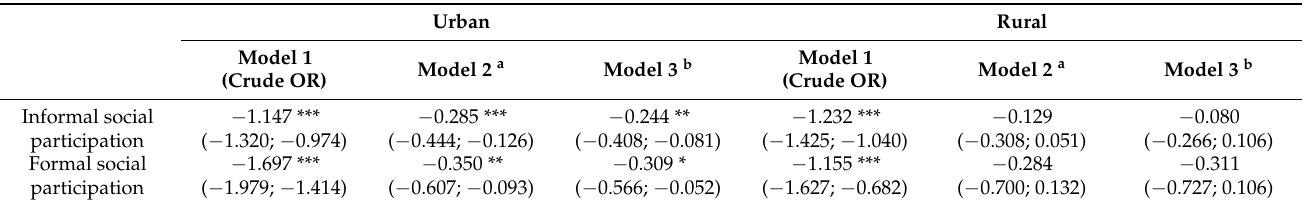
Table 3. Multiple linear regression analysis of the association between social participation and remaining teeth: urban vs